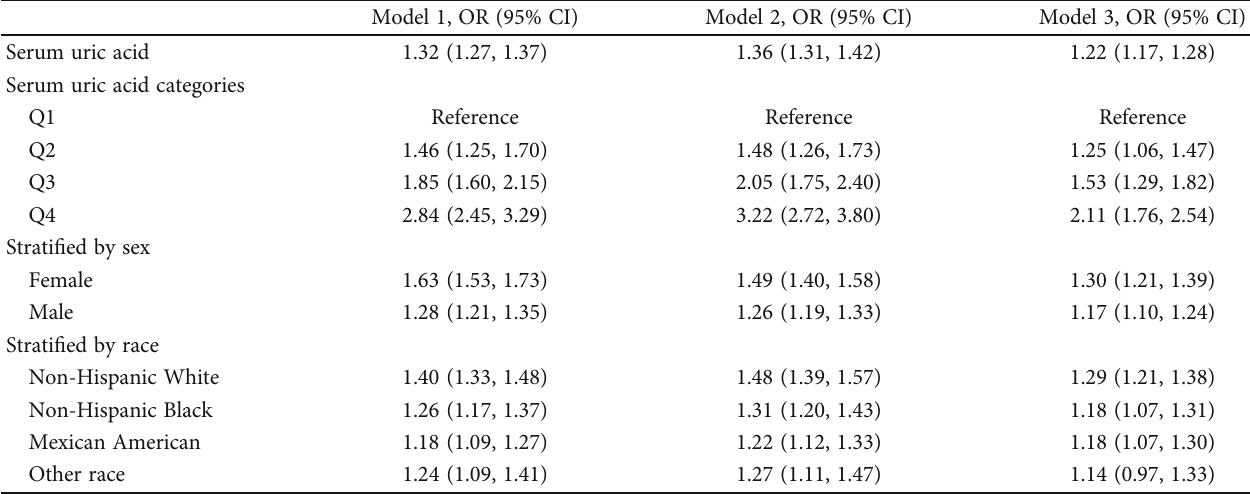
Table 2: Association between sUA and HTN.